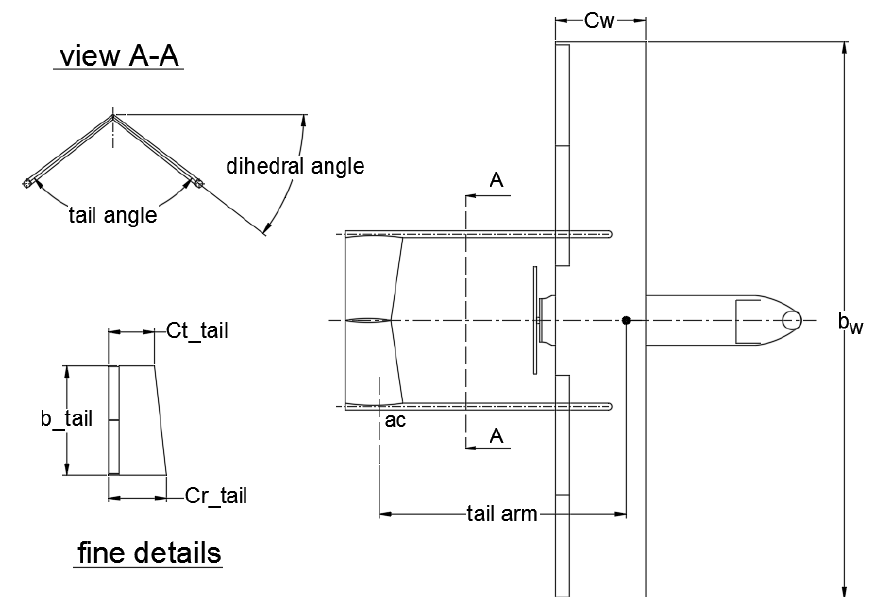
Figure 8. Definition of design variables for Aegis UAV with the V-tail shape. The Γ_tail is the dihedral angle in the figure.